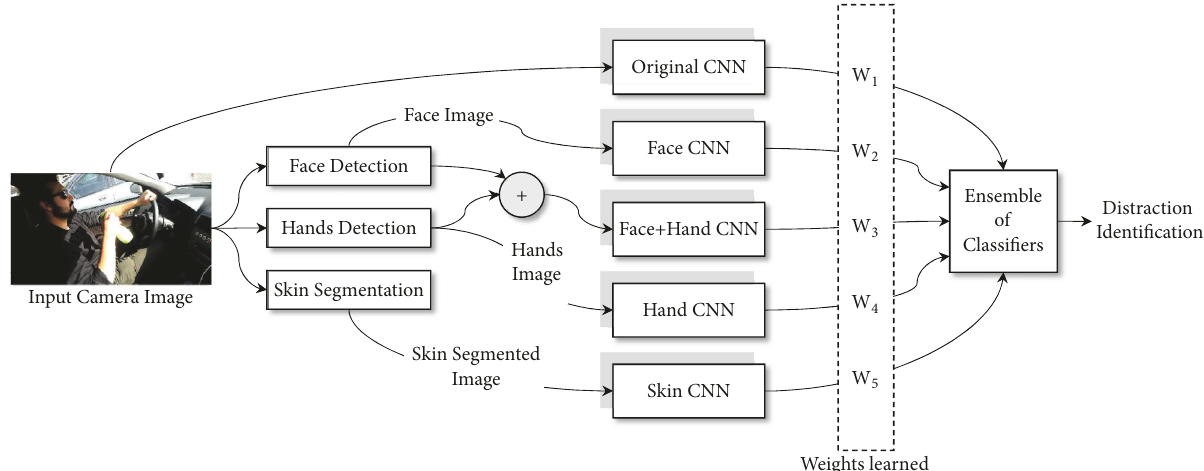
Figure 2: An overview of our proposed solution. A face detector, a hand detector, and a skin segmenter are run against each frame. For each output image (i.e., Skin, Face, Hands), an AlexNet and an InceptionV3 network are trained (i.e., resulting in 10 neural networks: 5 AlexNet and 5 InceptionV3). The overall class distribution is determined by the weighted sum of all softmax layers. The weights are learned using a genetic algorithm.